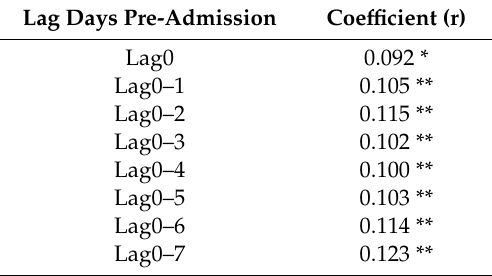
Table A1. Pearson correlation coe ffi cients between PM 2.5 and ozone concentration levels from Lag0 to